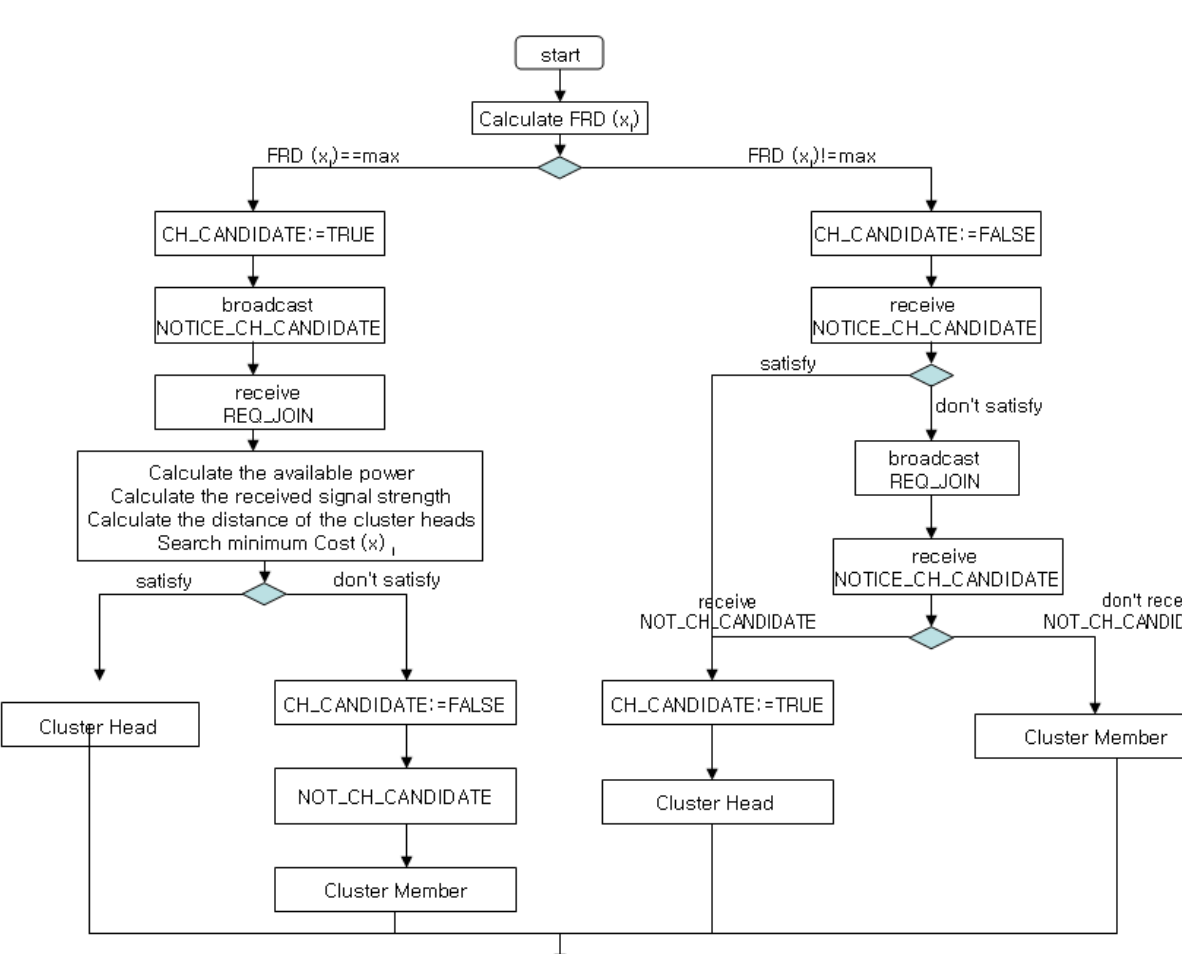
Figure 3. Flowchart for cluster head